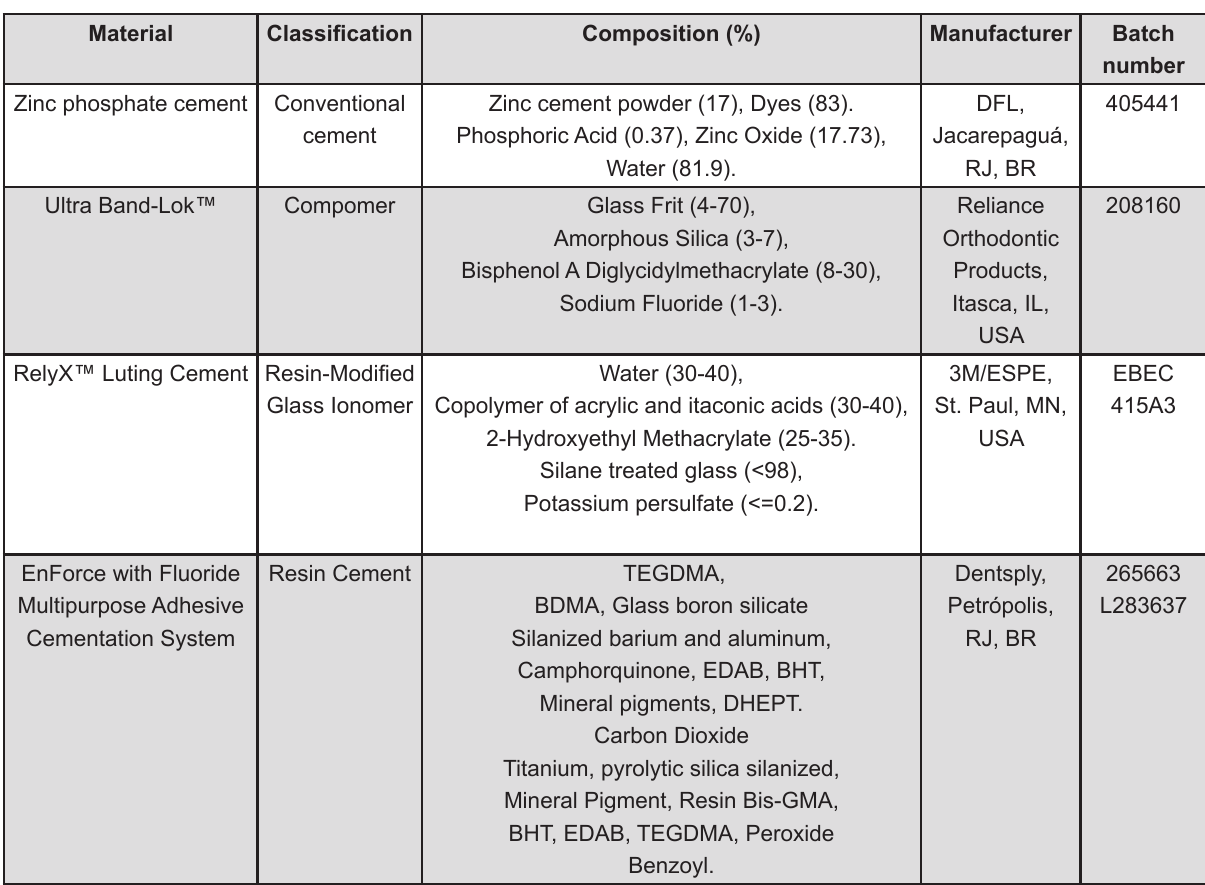
Figure 1- Materials used in this